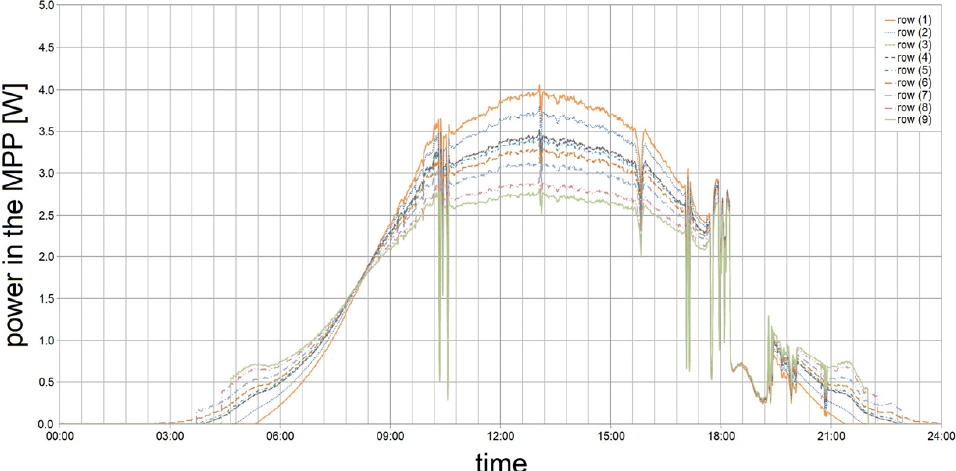
Figure 22. Simulated power at MPP ( P mpp ) for ψ = 180°.